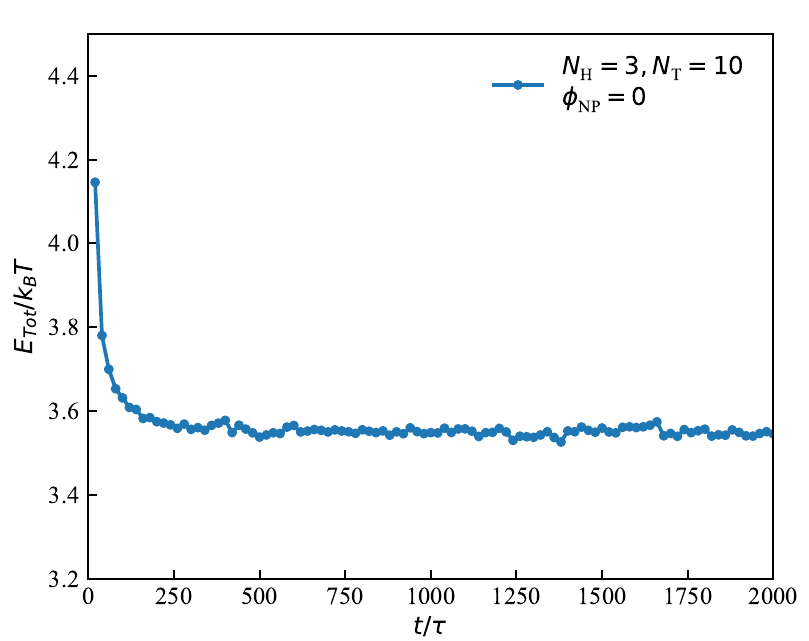
Figure 2. An example of obtaining the equilibrium state in the dynamic process with parameters N H = 3, N T = 10, the total energy E Tot /k B T as a function of time